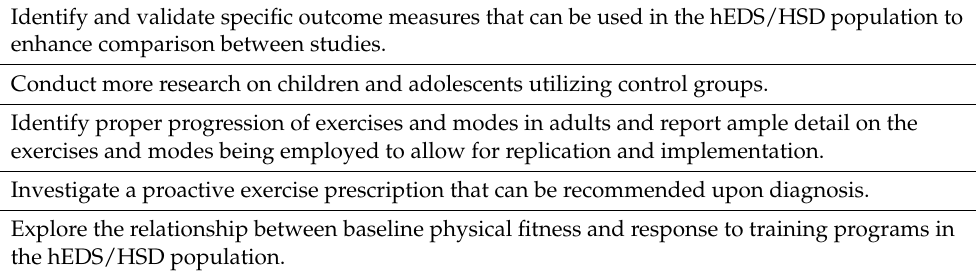
Table 4. Summary of Recommendations for Future